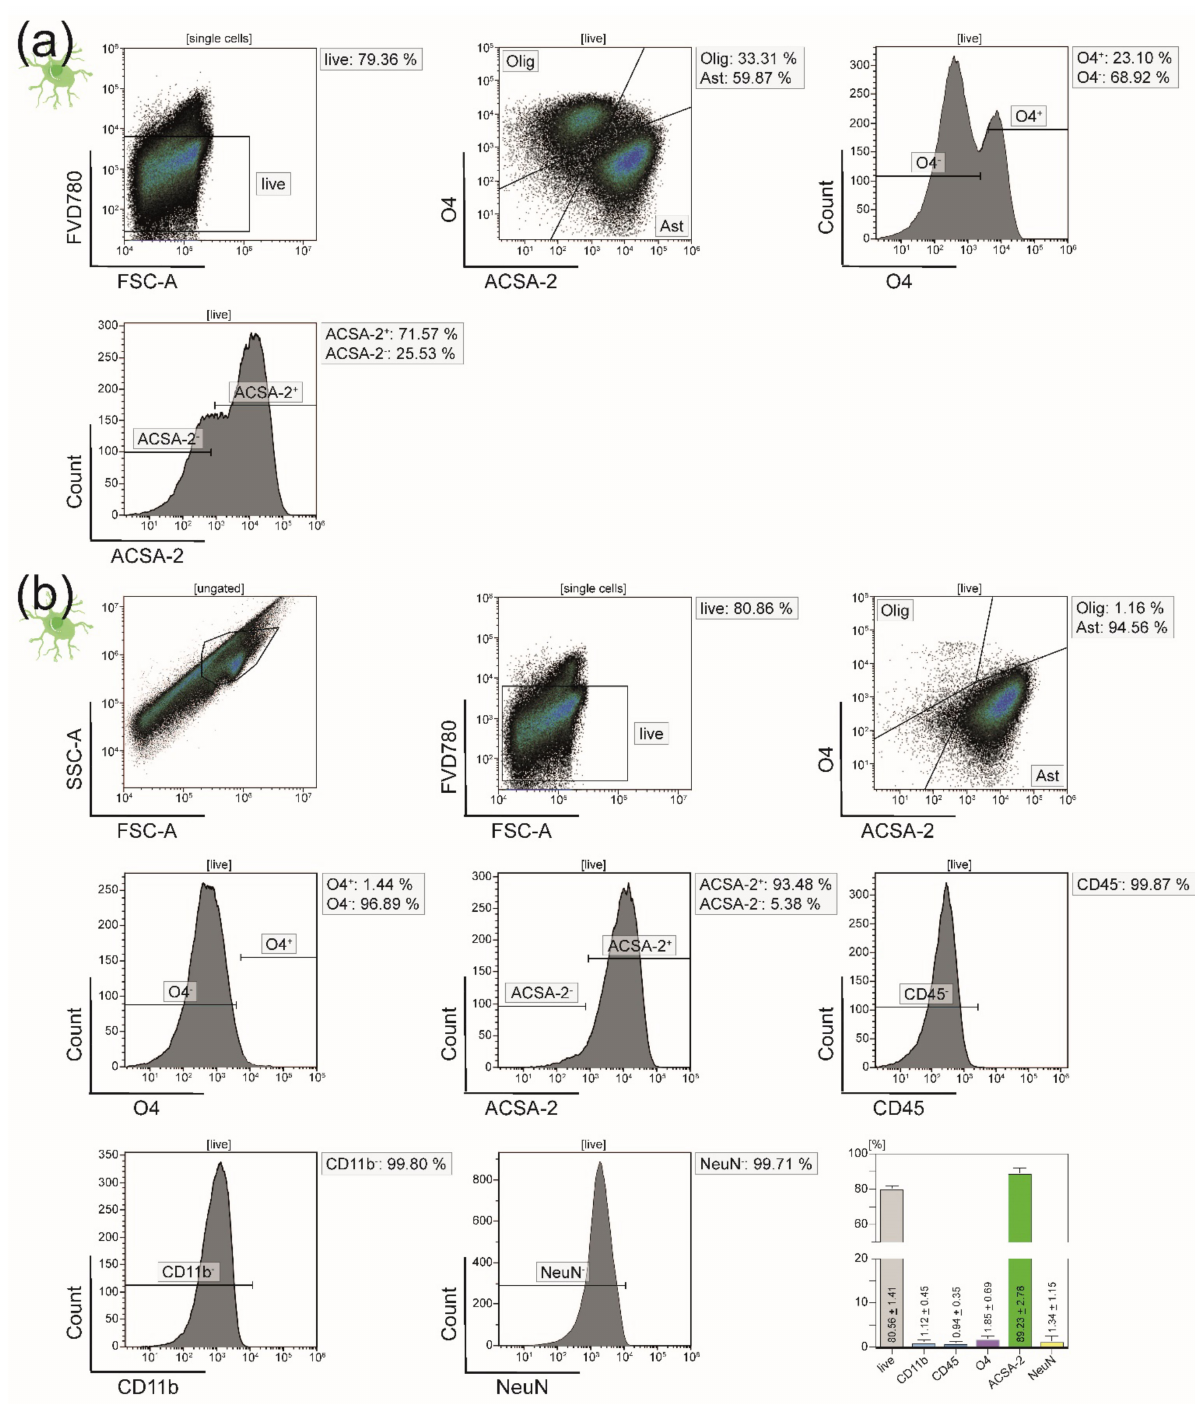
Figure 4. Flow cytometry analyses of astrocytes isolated from adult naïve mice . We chose ACSA-2 as a cell-type-specific marker for astrocytes. ( a ) Purity analysis of astrocytes isolated from adult naïve mice via anti-ACSA-2 MicroBeads showing a relevant 33.31% contamination with oligodendrocytes (O4 + cells). Only 59.87% of the isolated cells were believed to be astrocytes. ( b ) Representative purity analysis of astrocytes after isolation from the negative flow-through of oligodendrocytes. Oligodendrocytes were depleted successfully, leaving only 1.85% O4 + cells behind and thereby increasing the purity of astrocytes to 89.23%. The bar diagram illustrates the percentage of viable and ACSA-2 expressing astrocytes. Five biological replicates were measured. Means ± SEMs are depicted within the